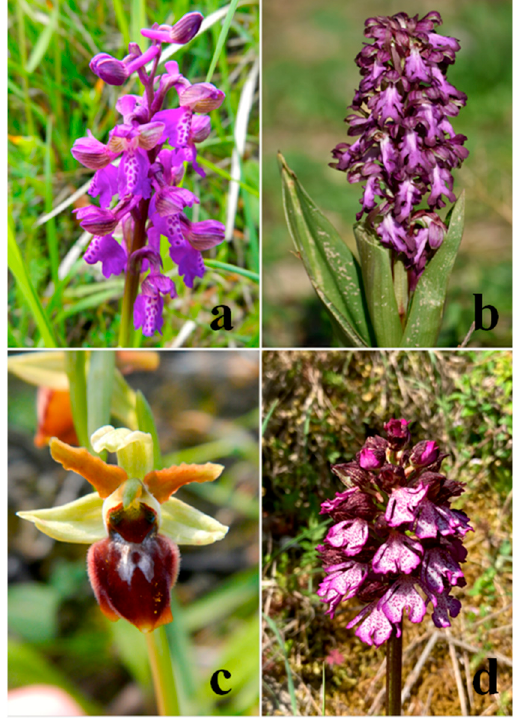
Figure 1. Orchid’s species selected for this study: Anacamptis morio ( a ); Himantoglossum robertianum ( b ); Ophrys sphegodes ( c ) and Orchis purpurea ( d ).